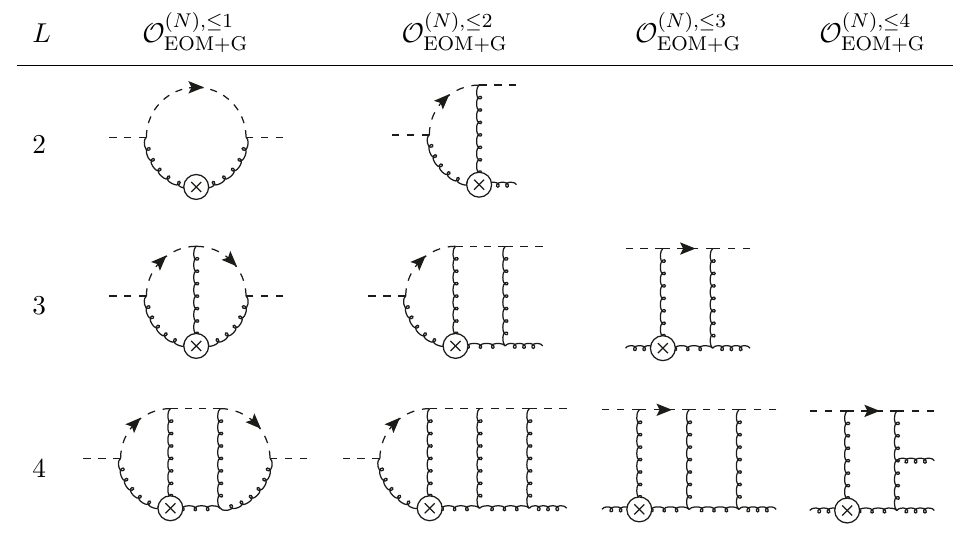
into both the EOM — and ghost 1 1; BB